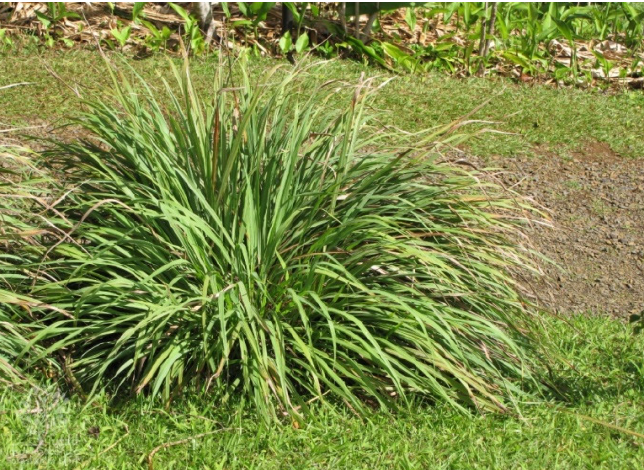
Figure 1. Aerial parts of Cymbopogon citratus (DC) Staph. Photograph by Forest and Kim Starr from Jardim Botânico UTAD, Flora Digital de Portugal (https://jb.utad.pt, accessed on 1 August 2022).